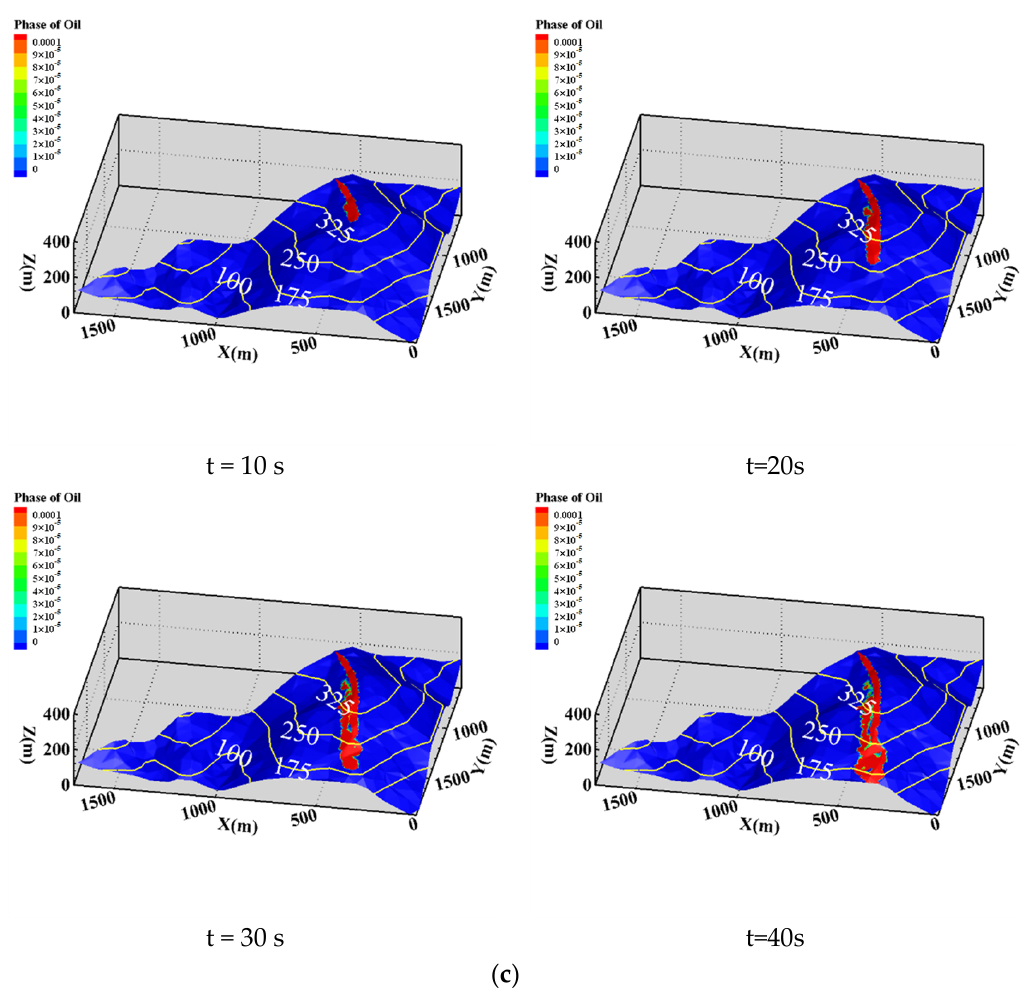
Figure 7. Diffusion patterns of the leaked crude oil when the leakage occurs at the ridge: ( a ) v = 30 m/s; ( b ) v = 50 m/s; ( c ) v = 80 m/s.